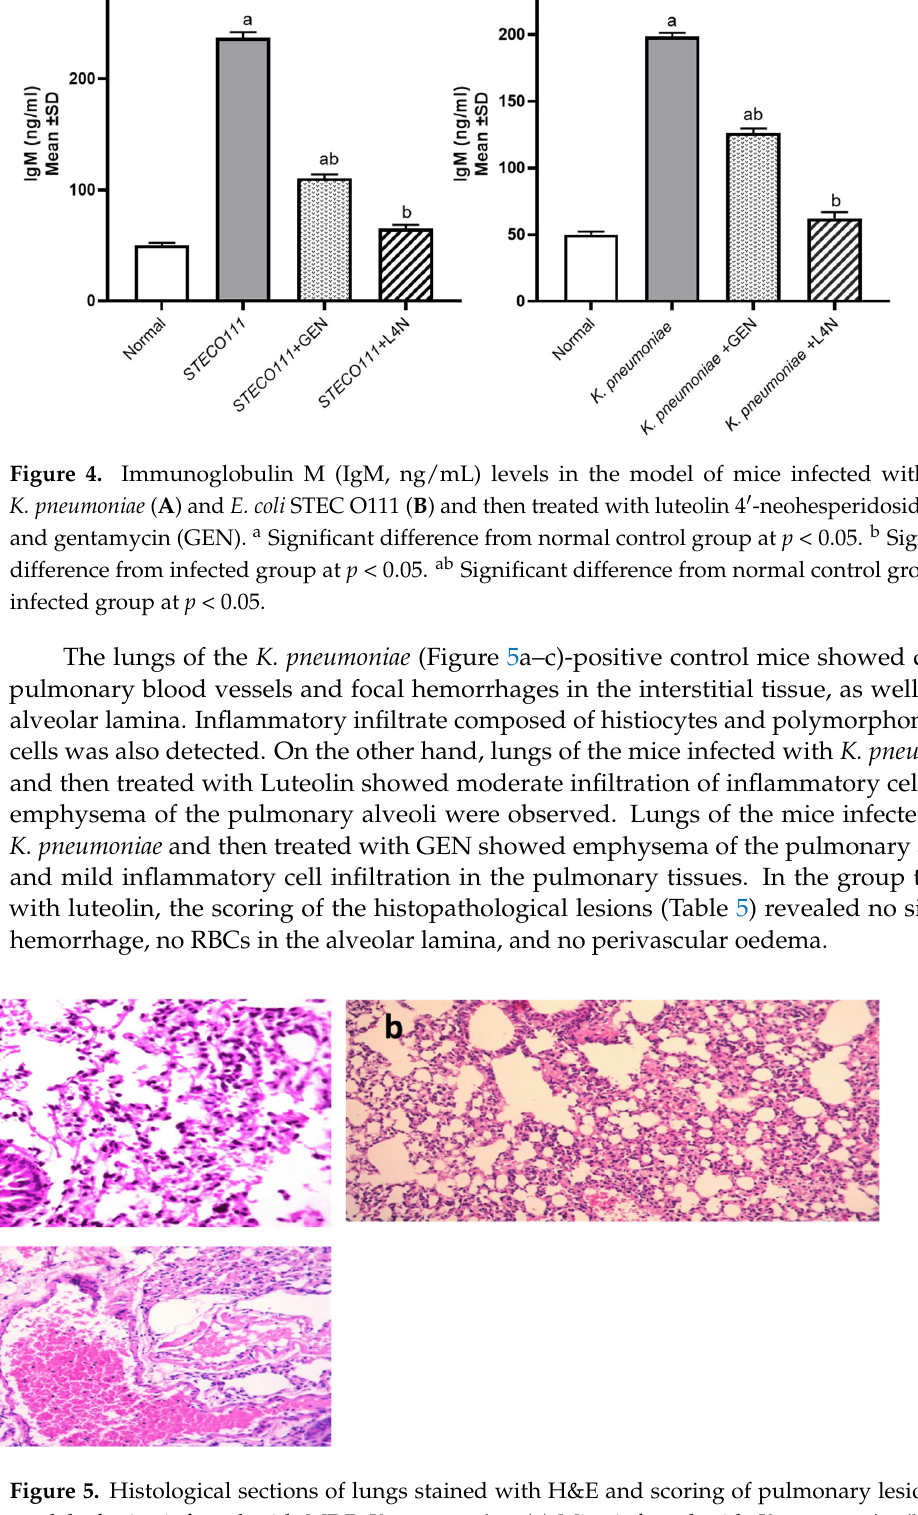
Figure 3. Tumor necrosis factor ‐ alpha (TNF ‐α , pg/mL) levels in mice infected with MDR K. pneumoniae ( A ) and E. coli O111 ( B ) and then treated with luteolin 4 ′‐ neohesperidoside (L4N) and gentamycin (GEN). a Significant difference from normal control group at p < 0.05. b Significant difference from infected group at p < 0.05. ab Significant difference from normal control group and infected group at p < 0.05.